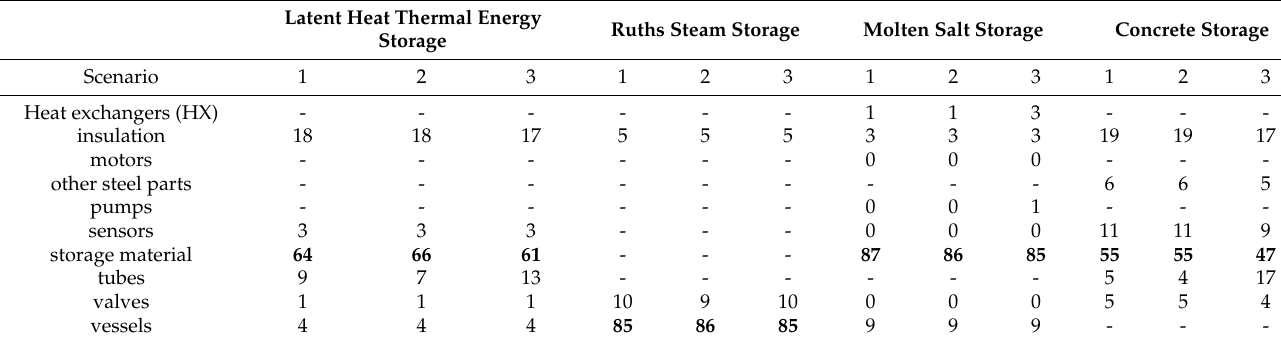
Table 6. Cost structure for Case 1 in percentage of total storage costs (rounded). Dominant cost drivers are printed in bold font. 1: Low Cap./Low HL, 2: High Cap./Low HL, 3: High Cap./High HL.